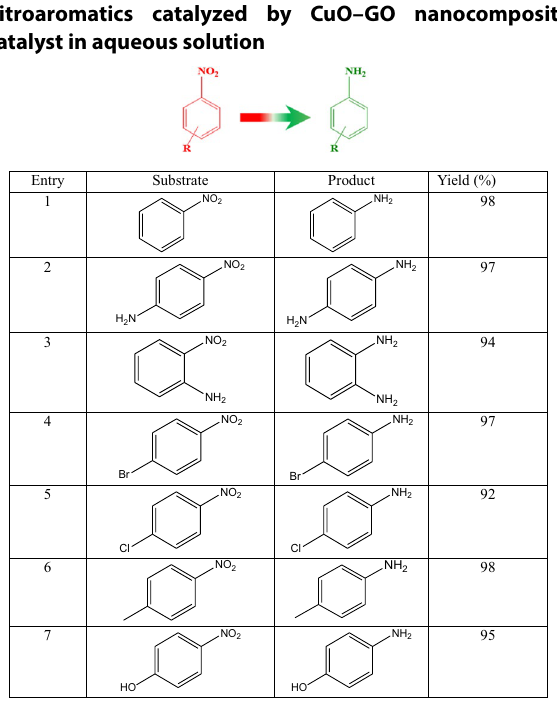
reduction of substituted nitroaromatics catalyzed by CuO–GO nanocomposite catalyst in aqueous